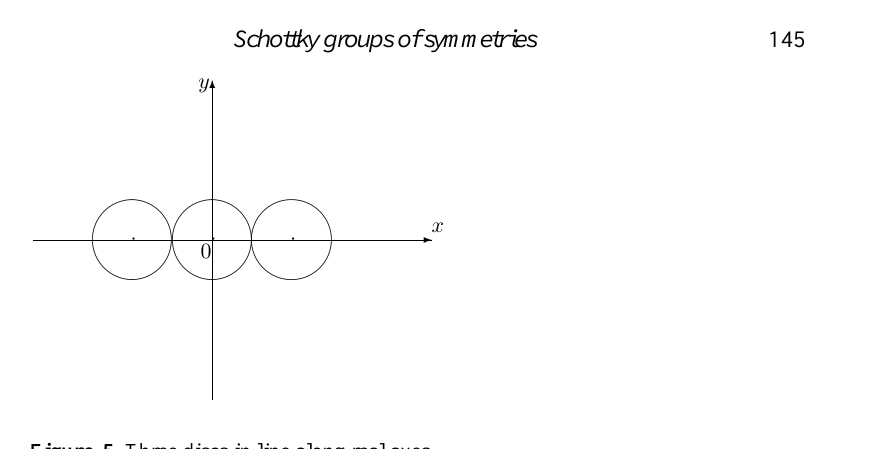
Figure 5. Three discs in line along real axes.